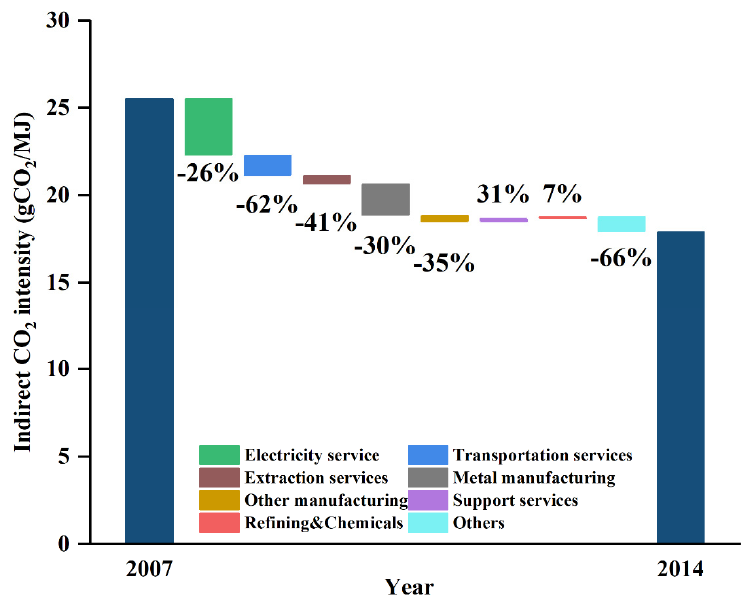
Figure 4. Changes in the indirect emission intensity of coal production in China.